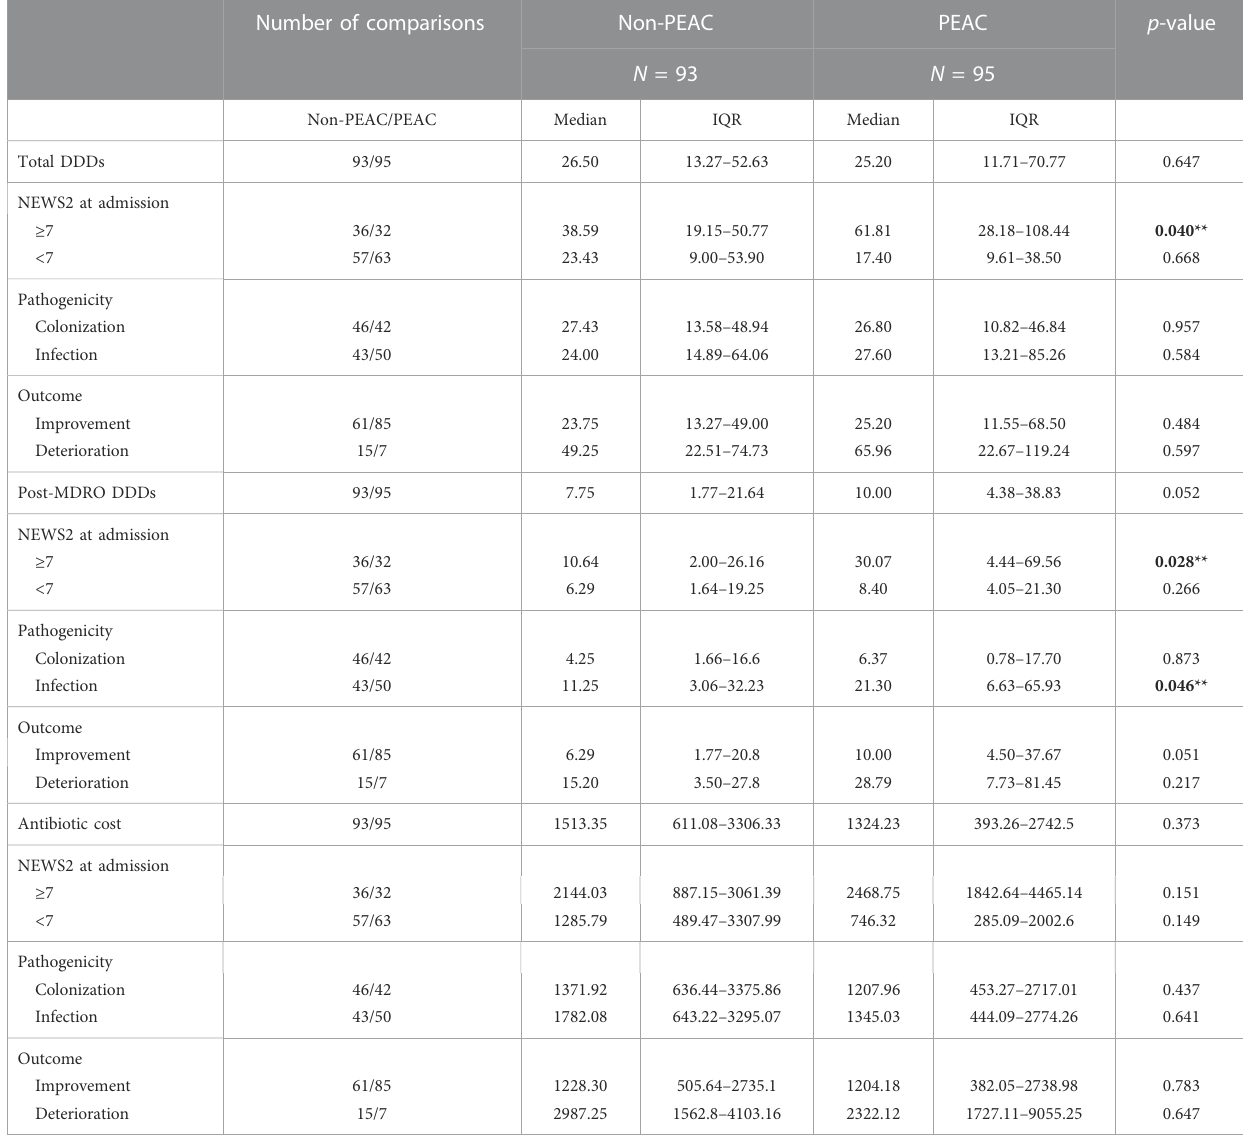
TABLE 4 Antibiotic consumption and cost for MDRO patients with or without PEAC. Number of comparisons